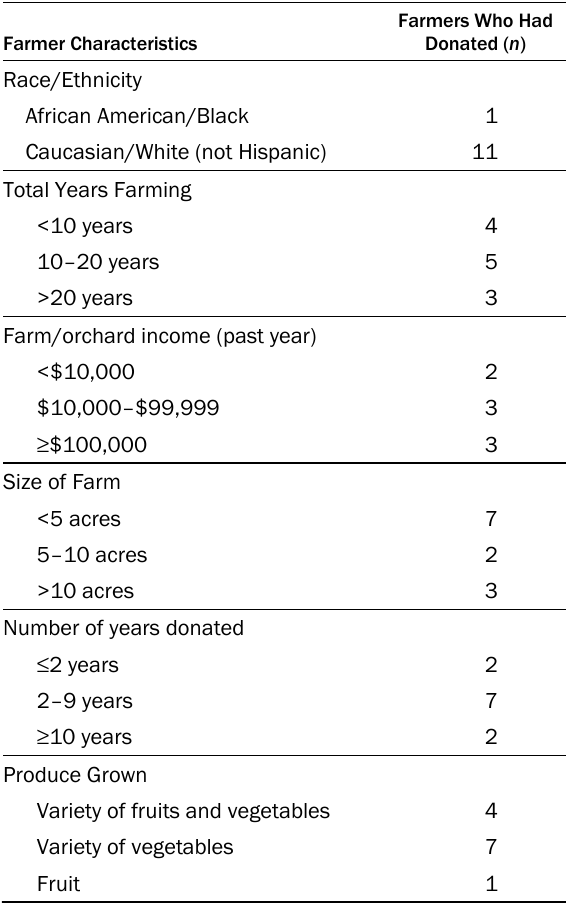
Table 2. Farmers Who Had Donated Demographic